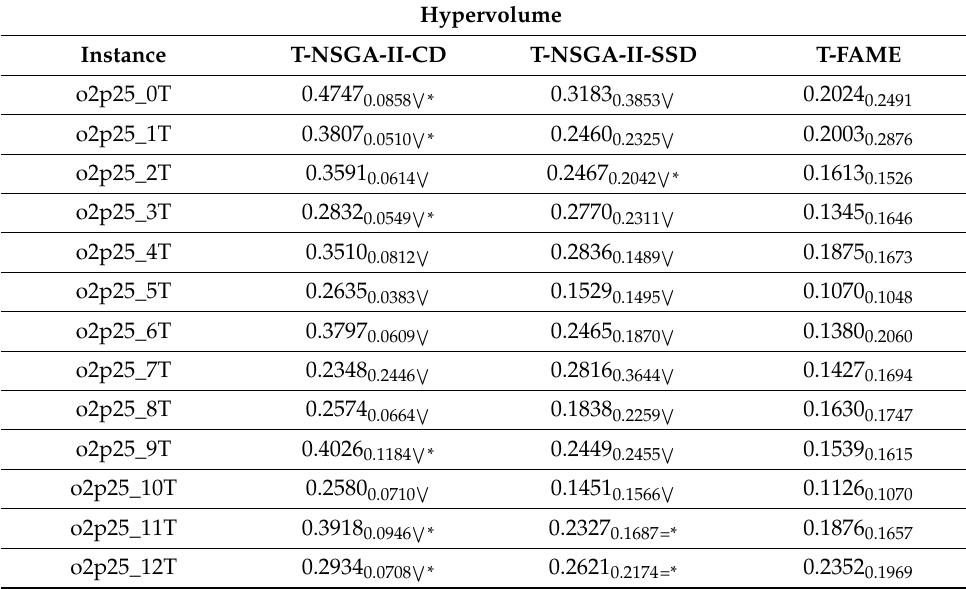
Table 10. Results with the hypervolume metric.